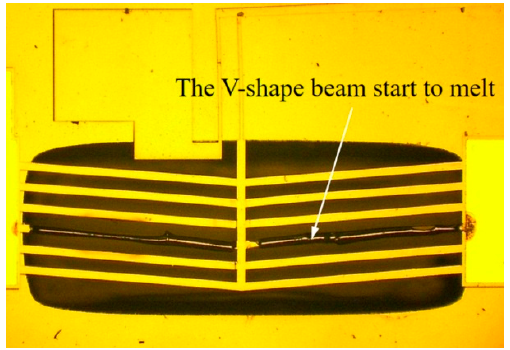
Figure 12. The V-shape beam start to melt with the input voltage of 19 V .